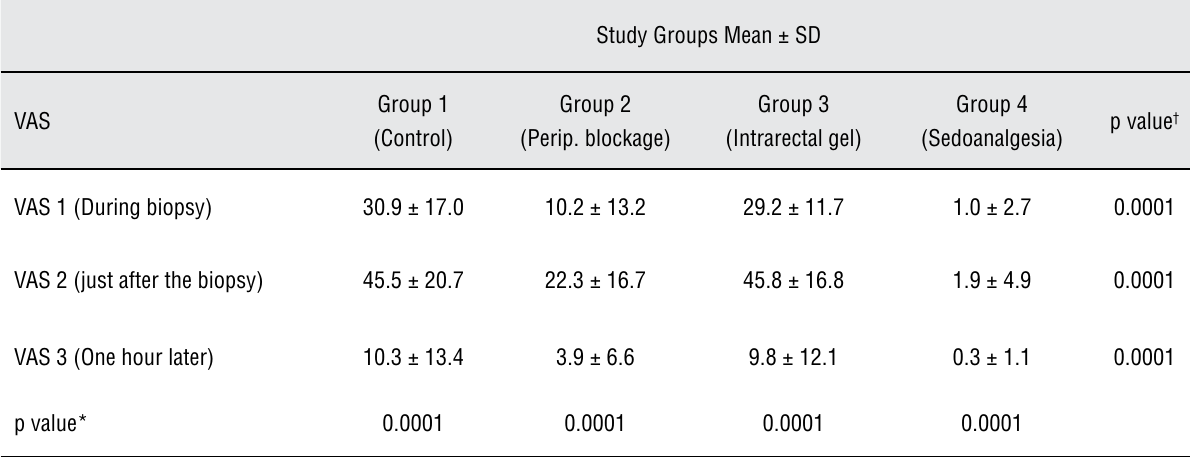
Table 2 - Distribution of pain scores between groups and time.